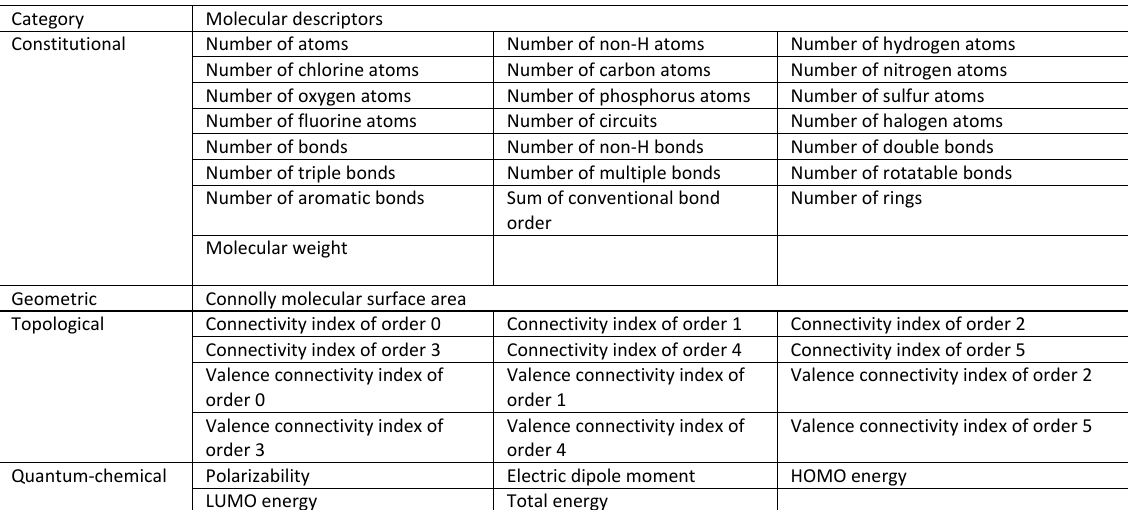
Table 1 – List of the 40 molecular descriptors in